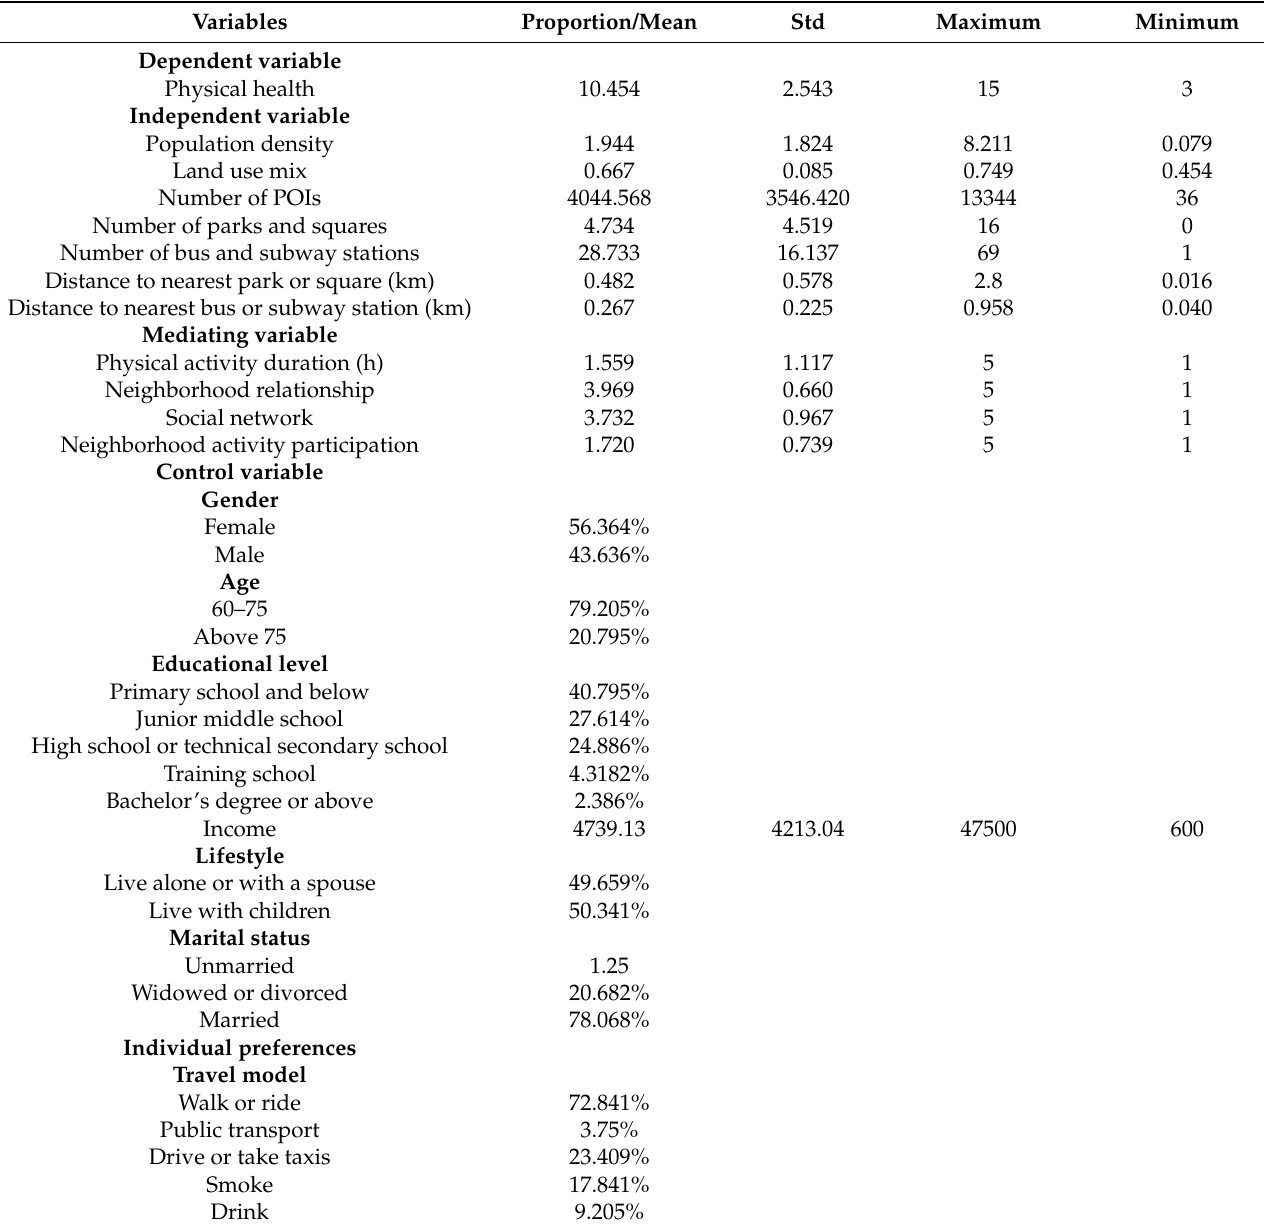
Table 2. Descriptive statistics of